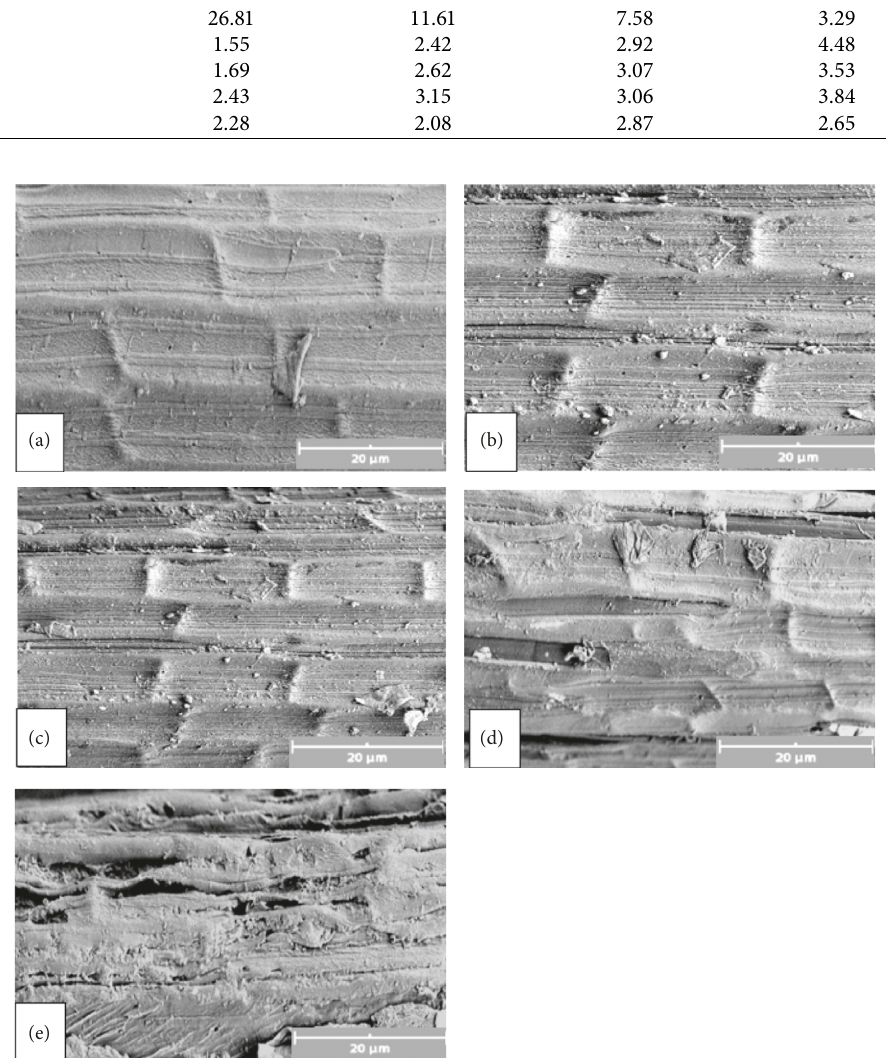
Figure 4: The results of the KPLF covering SEM photo: (a) TP, (b) P1J (c) P2J, (d) P3J, and (e)